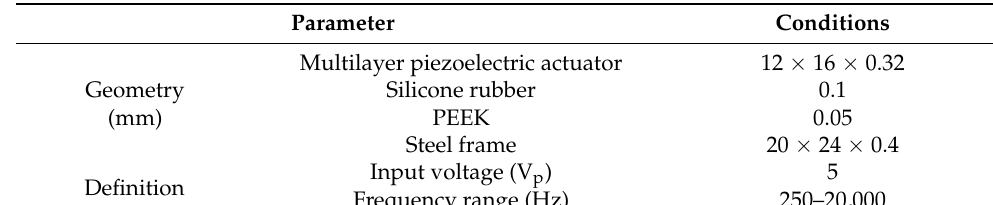
Table 1. Constituent materials and analysis conditions for the ATILA simulation of the piezoelec- tric speakers.